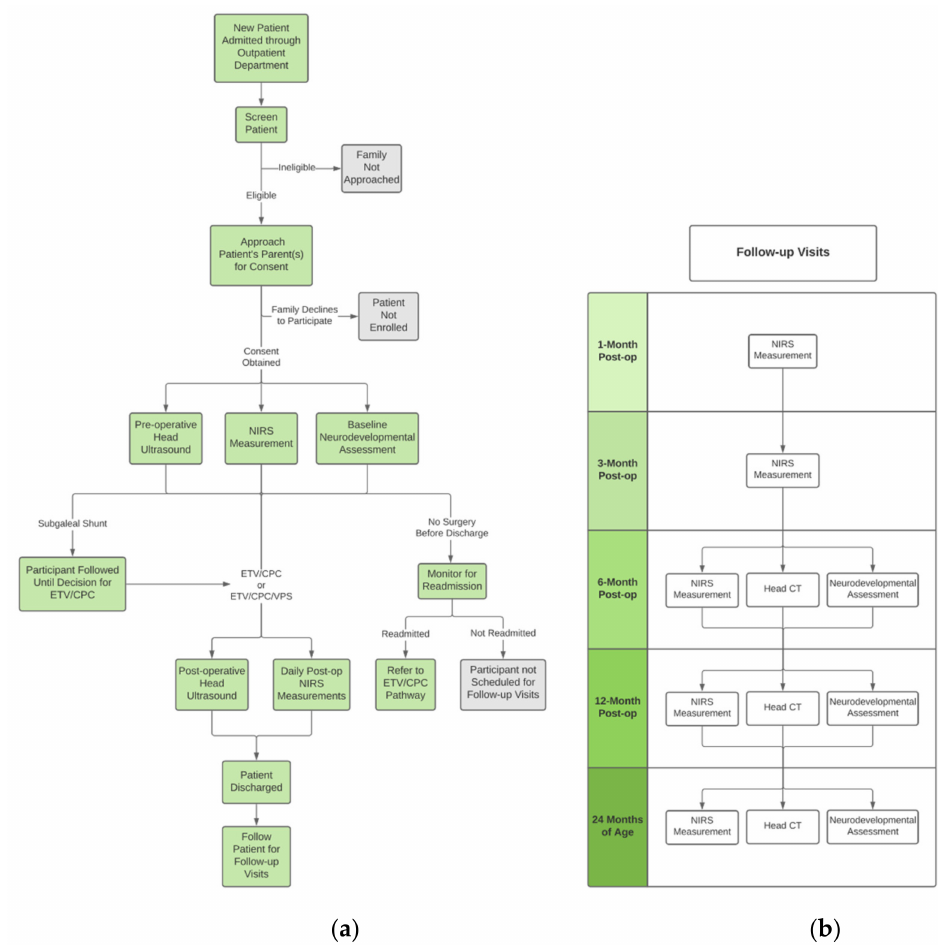
Figure 1. ( a ) Clinical and research workflow, ( b ) Scheduled patient research follow-ups.